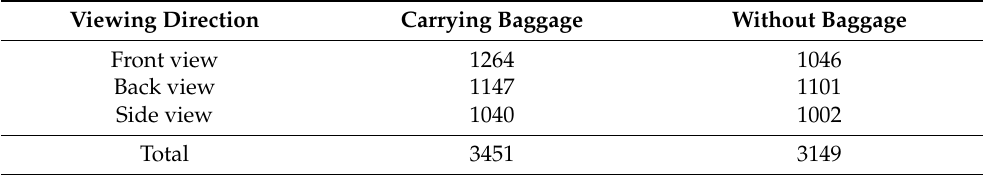
Table 4. MSMT17 dataset